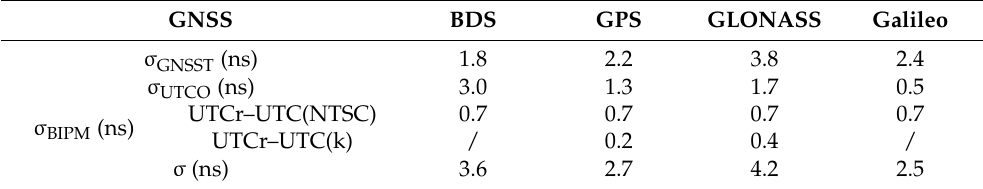
Table 2. The uncertainty budget for GNSS time transfer accuracy